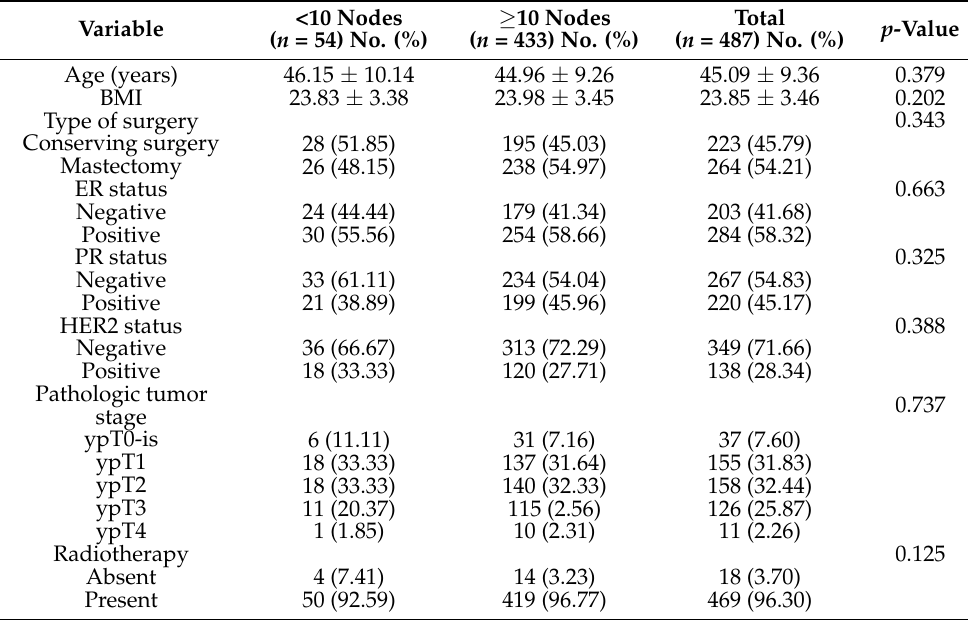
Table 3. Characteristics of the pathologic node-positive patients’ group according to lymph node dissection